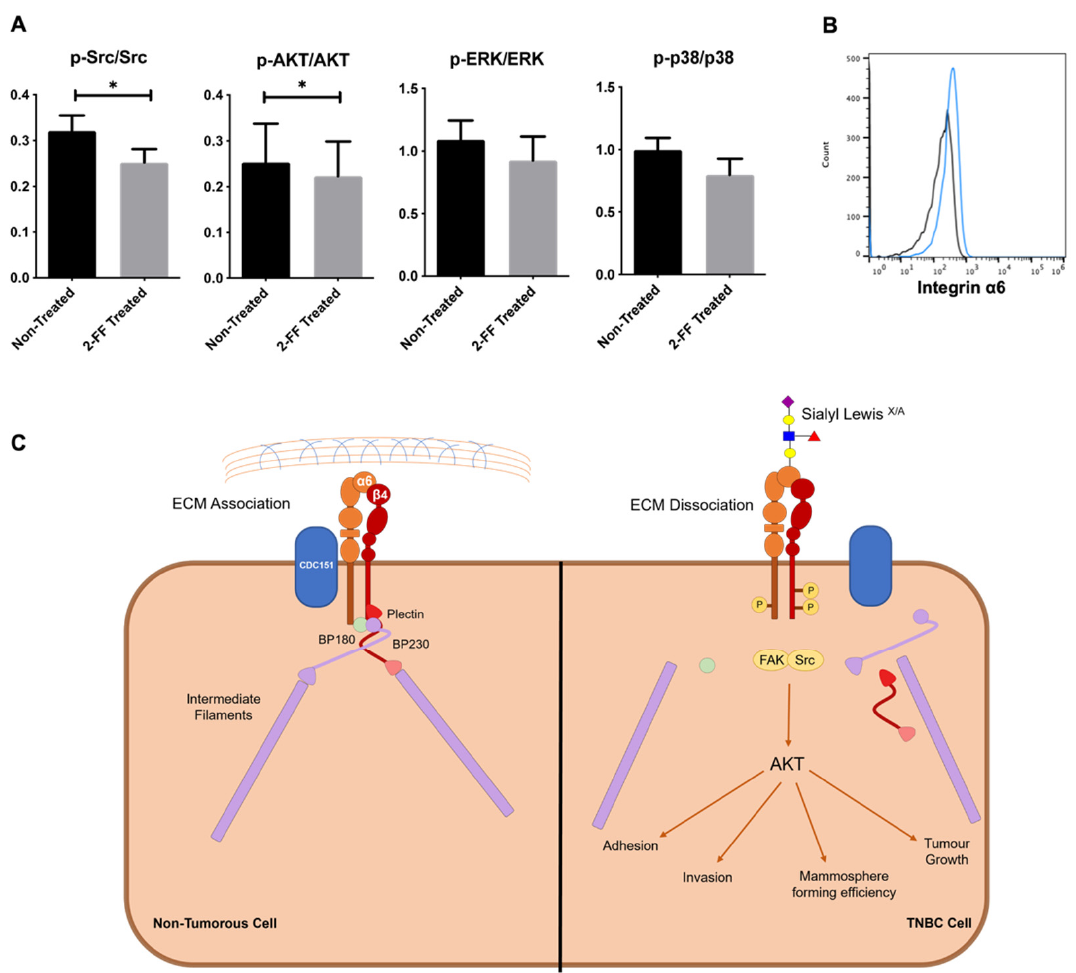
Figure 4. α 6 integrin-associated pathways are affected upon 2-FF treatment. ( A ) Expression of phos- phorylated proteins is affected by 2-FF. CF1_T cell line treated with 2-FF for 5 days were analysed regarding their expression of phosphorylated Src (p-Src), AKT (p-AKT), ERK1/2 (p-ERK), and respec- tive total proteins by flow cytometry. Ratio between phosphorylated versus total protein expression is represented in the graphs (n = 3, p < 0.05 (*)). ( B ) CF1_T cells express α 6 integrin. Flow cytometry analysis of CF1_T cells stained with anti- α 6 integrin antibody, plus fluorescent secondary antibody. Representative histogram showing positive staining (blue line). Cells stained only with fluorescent secondary antibody and without anti- α 6 integrin antibody were used as a negative control (dark line); ( C ) Proposed mechanism of the influence of sLe X/A decoration of α 6integrin on cytokeratin expression. The crosstalk between α 6 integrin and cytokeratins is established by the hemidesmosome (complex of α 6 β 4 integrin, plectin, BP180, CD151, BP230). sLe X/A decoration activates integrin and the downstream signalling pathways, contributing to a more aggressive